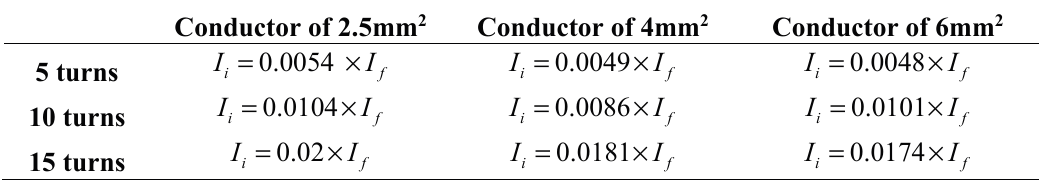
Table 3. Mathematical models for I i versus I f